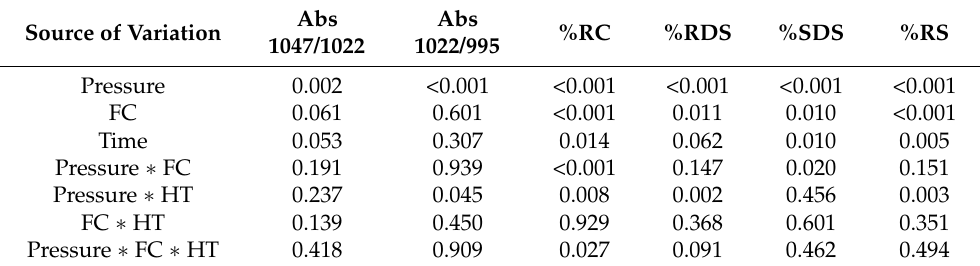
Table 1. Summary of probability values after three-way ANOVA analysis of absorbance ratios, %RC, and starch digestion fractions as affected by pressure, flour concentration (FC), and holding time (HT). Source of Variation